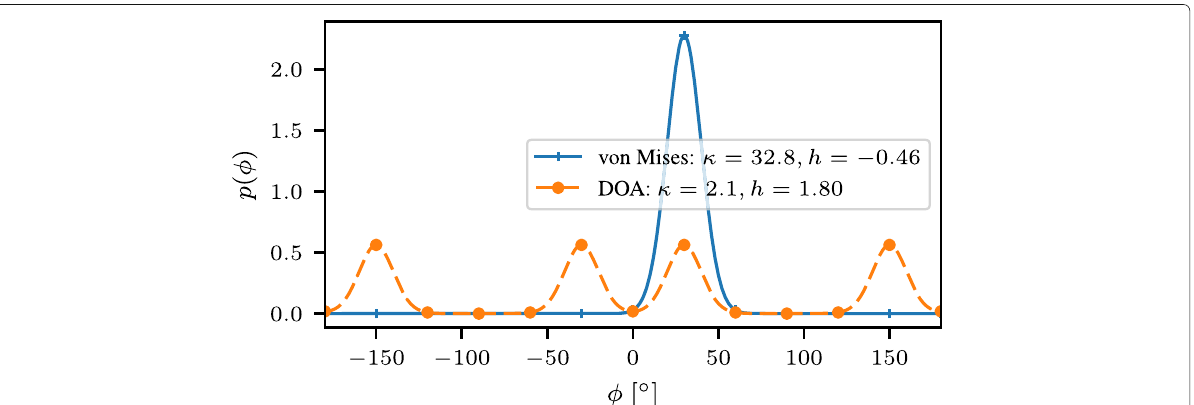
Fig. 11 PDFs for the unambiguous and the ambiguous DOA sensor for φ = 30° with a standard deviation of σ = 15° sketched in blue and orange,